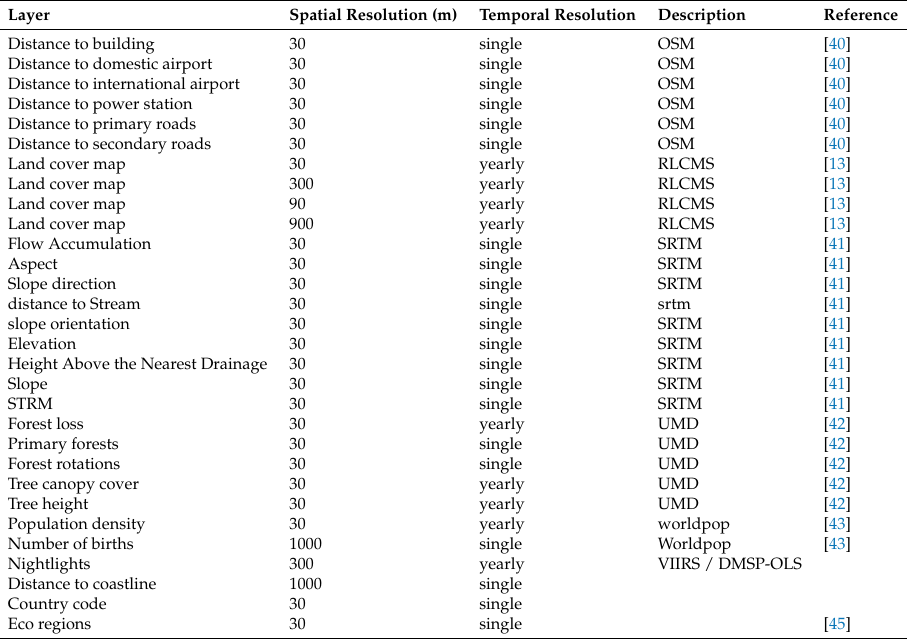
Table 3. Data layers used in the remote sensing